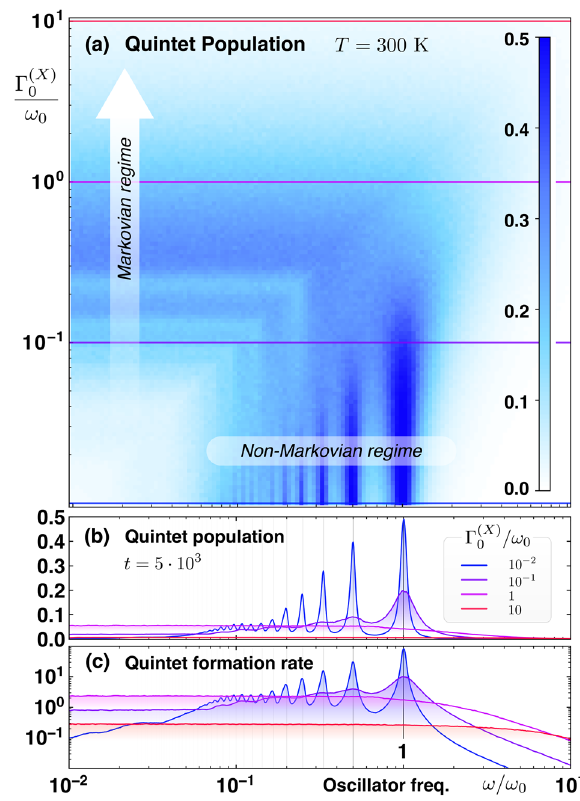
Fig. 4 Quintet formation driven by harmonic conformational dynamics. a Quintet population for t = 5000 periods ( ℏ / ε 0 ), at T = 300 K, as a function of the oscillator frequency ω and oscillator dephasing rate Γ ð X Þ 0 (frequencies and rates expressed in units of ω 0 = ε 0 / ℏ , 1000 trajectories for each point). Here ℏ is the reduced Planck constant, and ε 0 is de fi ned in Supplementary Note 2. We depict quintet population ( b ) and quintet formation rate ( c ) along slices of constant Γ ð X Þ (see the legend.) Quintet 0 formation rate γ is extracted from population data as a fi t to p 5 ð t Þ ¼ ½ 1 (cid:5) exp ð(cid:5) γ t Þ(cid:4) = 2. Pronounced resonance peaks can be seen for Γ ð X Þ (cid:6) ω (non-Markovian regime) at ω = ε 0 / ℏ k , with k positive natural 0 numbers. Their positions are prescribed by the diabatic limit ( ω ≫ Δ 2 / A ) of multiple-passage Landau – Zener – Stückelberg theory (LZS) 47 . Increasing Γ ð X Þ decreases the coherence of the oscillator, so there is less opportunity 0 for the Stückelberg phase of the triplet pair to accumulate over several periods of oscillation. This results in the resonance peaks broadening to the point of indistinguishability for moderate Γ ð X Þ (cid:7) ω (Markovian regime). See 0 Supplementary Note 1 for parameters of the spin